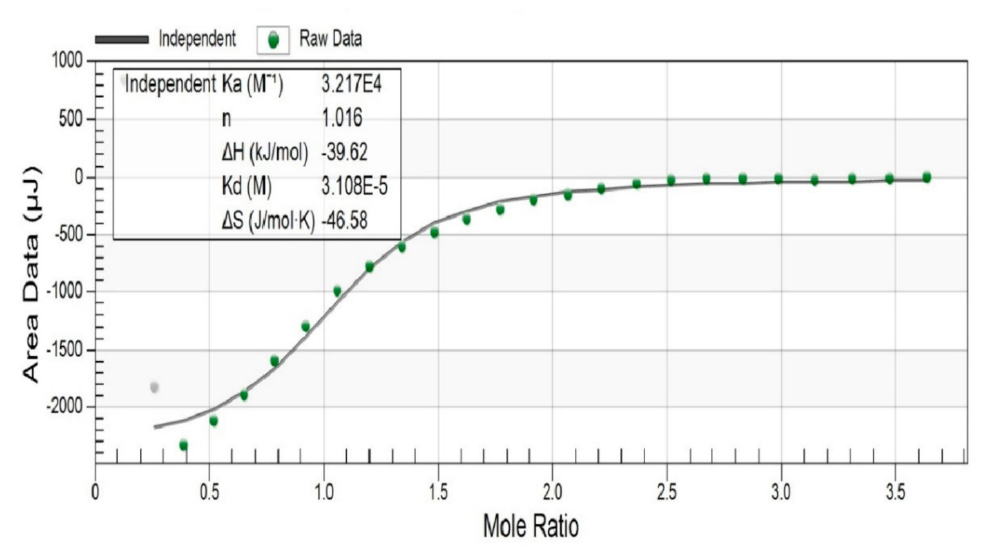
Figure 5. The experimental (depicted in the points) and fitted (depicted in the solid lines) plots of the binding heat e ff ect versus the clathrochelate 3 -to-BSA (bovine serum albumin) molar